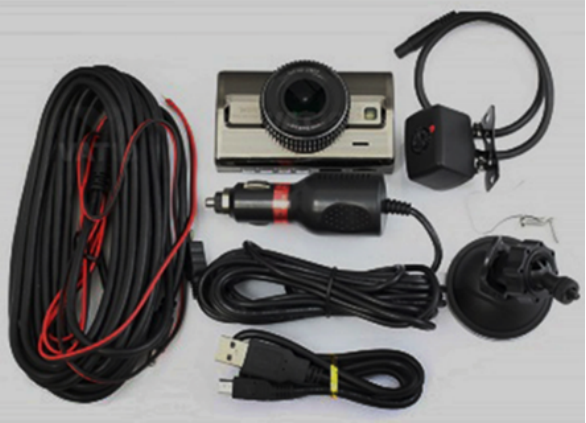
Figure 2: Lens set with the necessary cables [20].